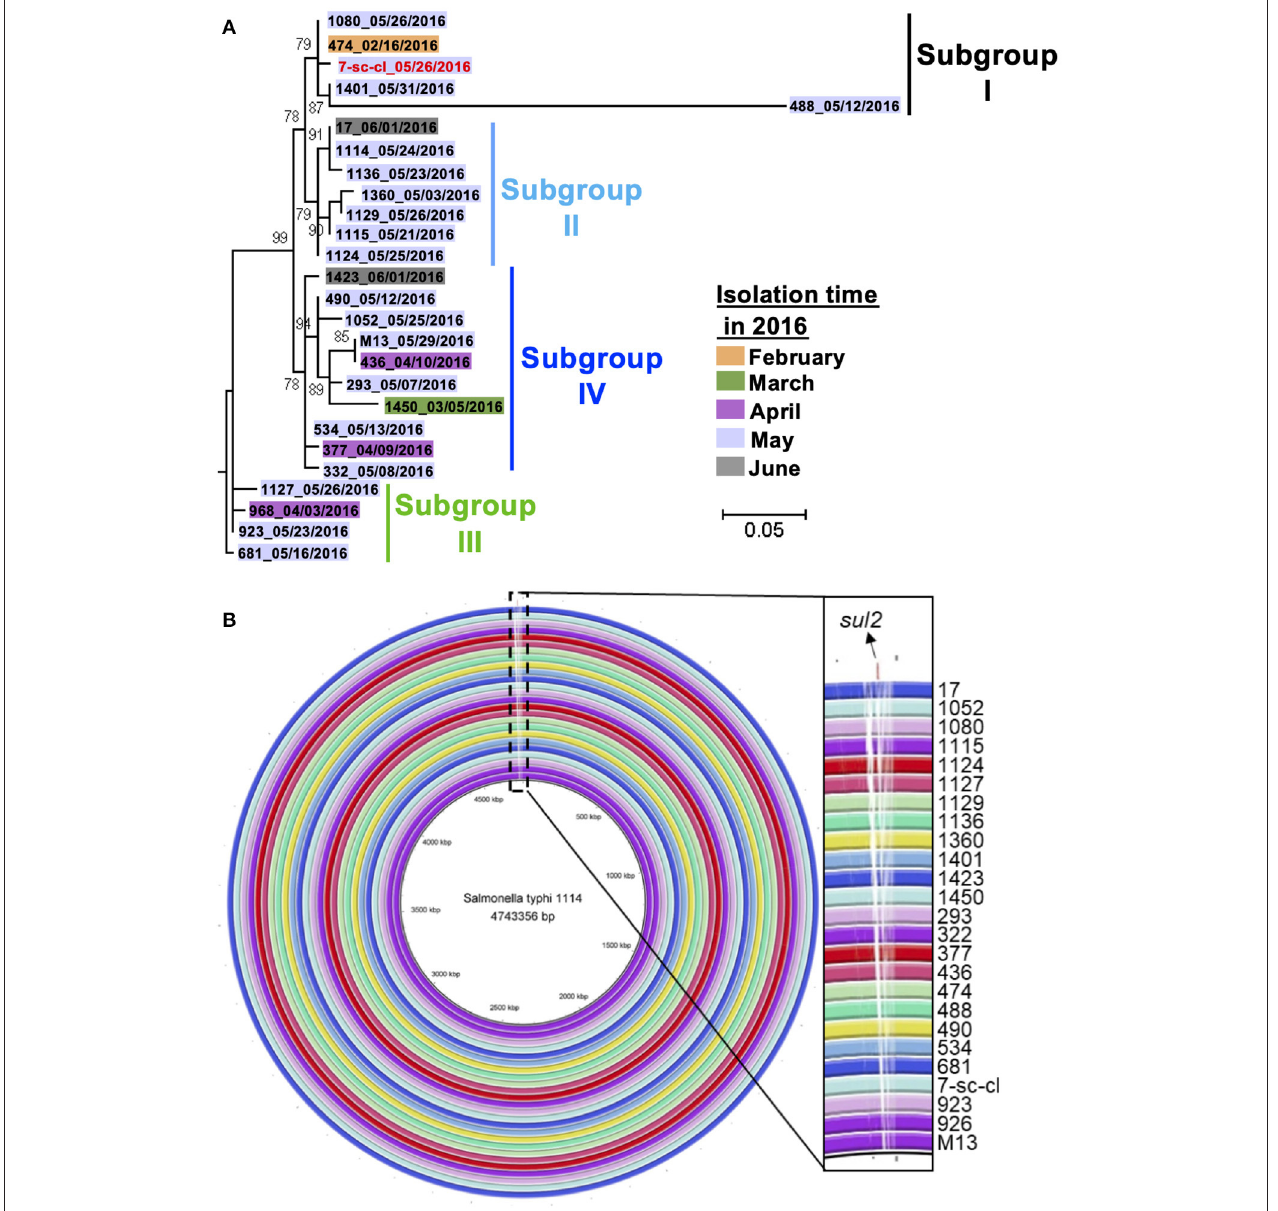
FIGURE 3 | Relatedness of S. Typhi outbreak isolates. (A) Phylogenetic relatedness of S. Typhi outbreak isolates in this study. A maximum-likelihood phylogenetic tree of 26 S. Typhi isolates was generated using Parsnp based on core-genome SNPs. These isolates are from patients’ stools ( n = 25, black color) and a water sample ( n = 1, red color). (B) Whole-genome alignment of 26 S. Typhi outbreak isolates. The genomic sequences of 25 isolates were aligned to that of the reference strain, i.e., 1114, by BRIG. The white blocks in each ring indicate the regions are absent in query isolates but present in the reference